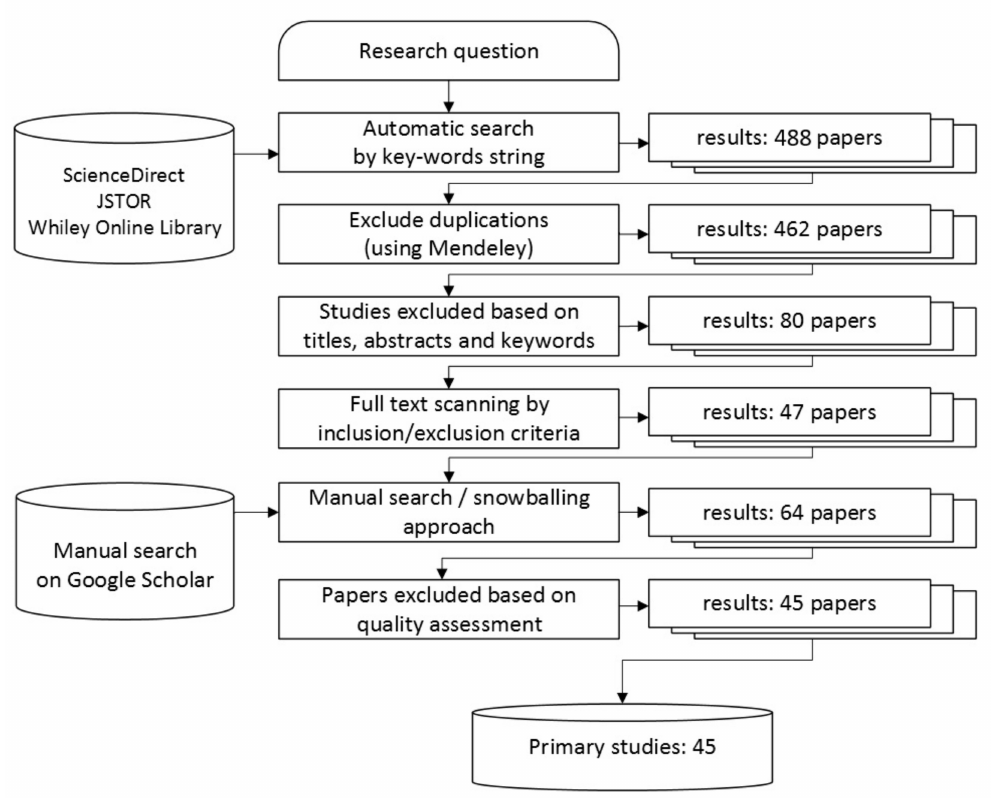
Figure 2. Flow diagram of the search and selection